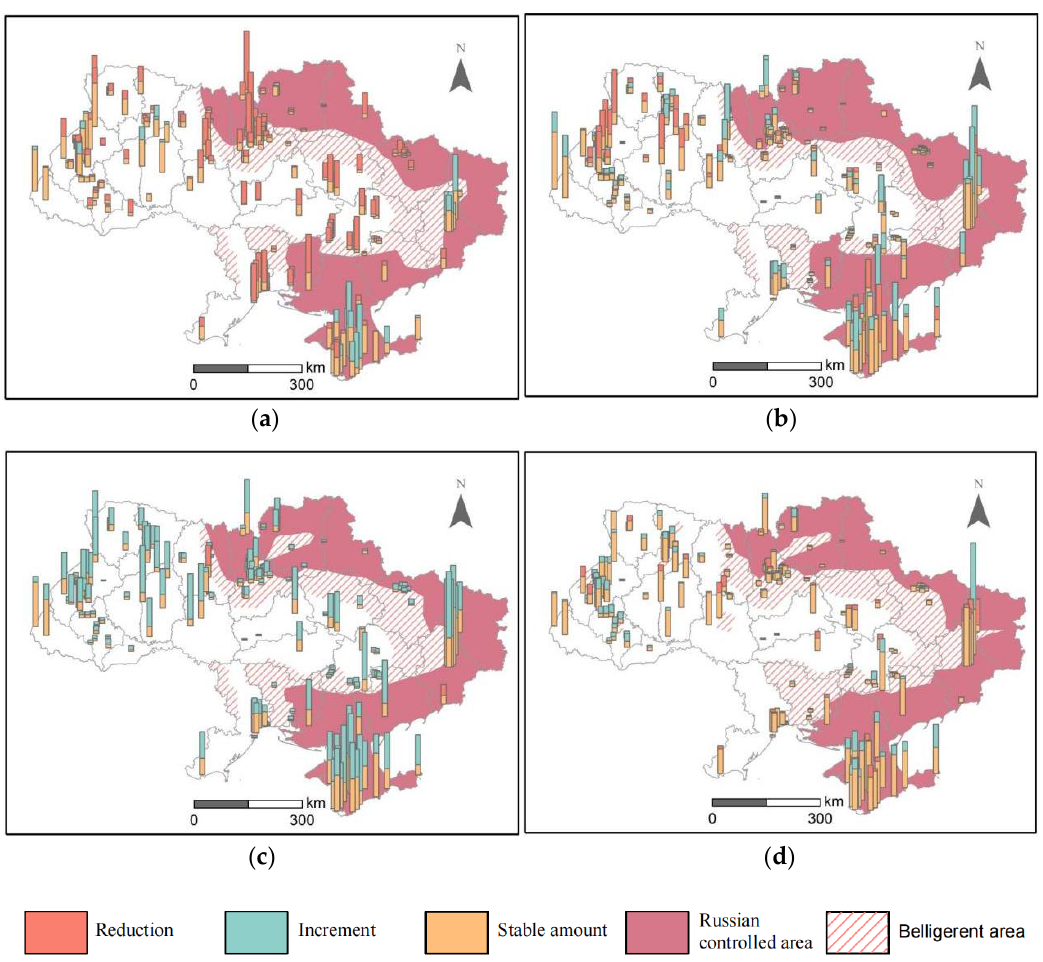
Figure 6. Dynamics of night-time light in Ukraine during the five negotiation events: ( a ) dynamics of night-time lighting during the first and second negotiations; ( b ) dynamics of night-time lighting during the second and third negotiation; ( c ) dynamics of night-time lighting during the third and fourth negotiations; and ( d ) dynamics of night-time lighting during the fourth and fifth negotiations.